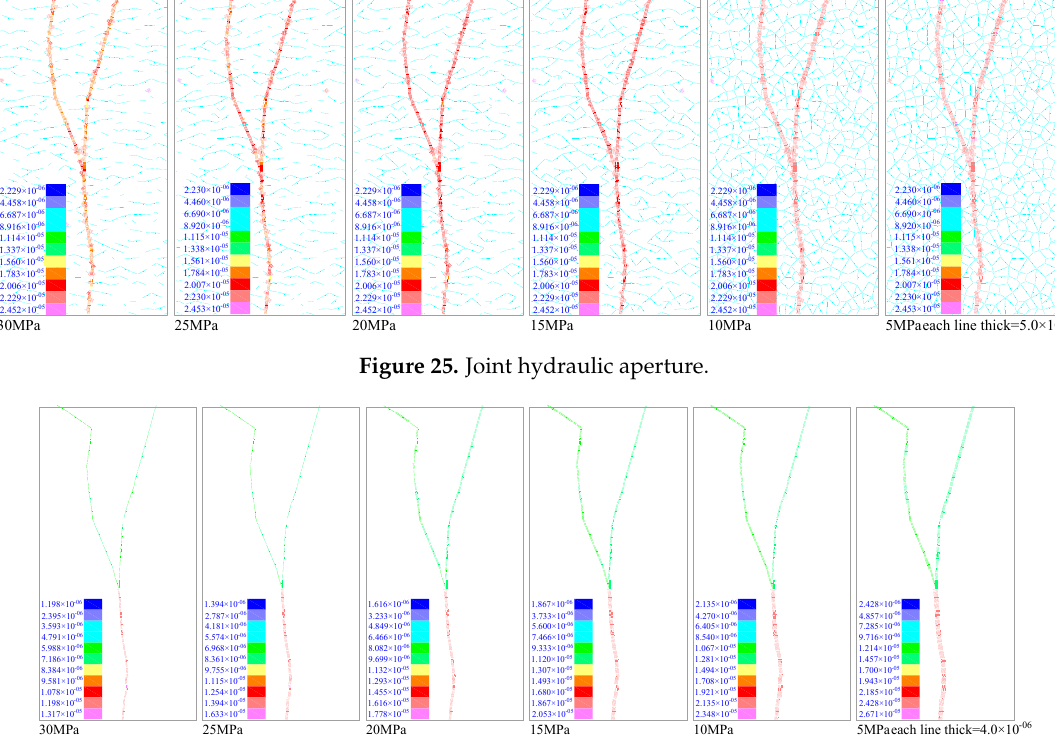
Figure 26. Main seepage channel.